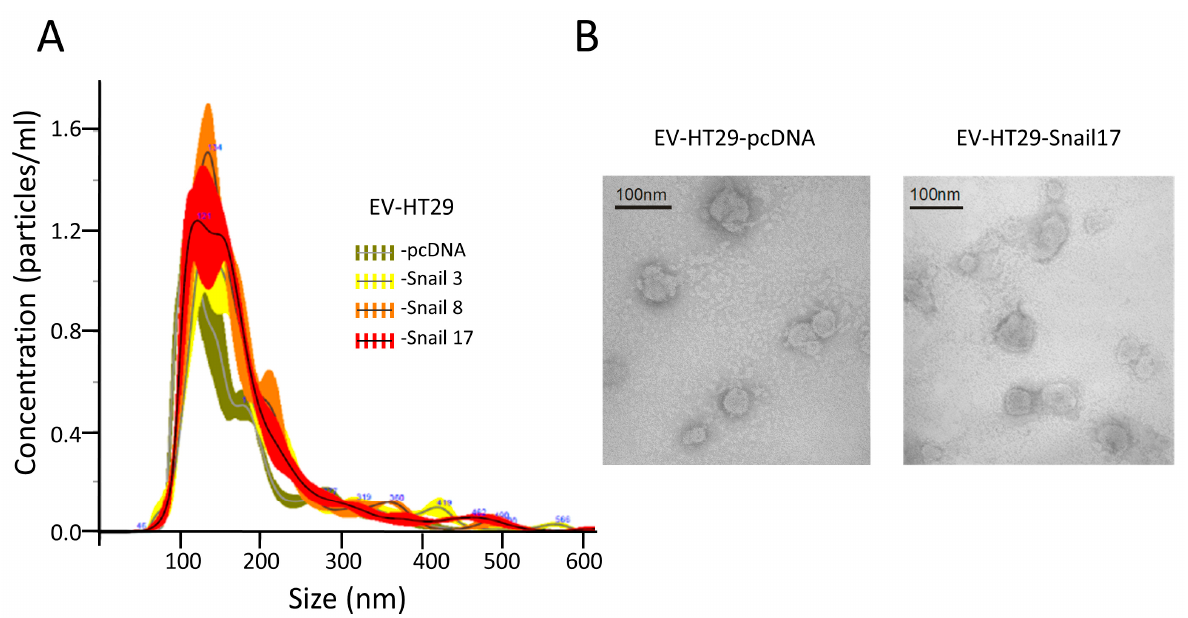
Figure 1. Characterization of extracellular vesicles (EVs) released by HT29 clones. EVs were isolated from conditioned media after 24 h of incubation in FBS-free culture media of HT29 clones. ( A ) NTA showed similar numbers and sizes of EVs isolated from HT29 clones. ( B ) Representative Electron microscopic image of EVs derived from HT29-cDNA and HT29-Snail 17. Scale bar, 100 nm.